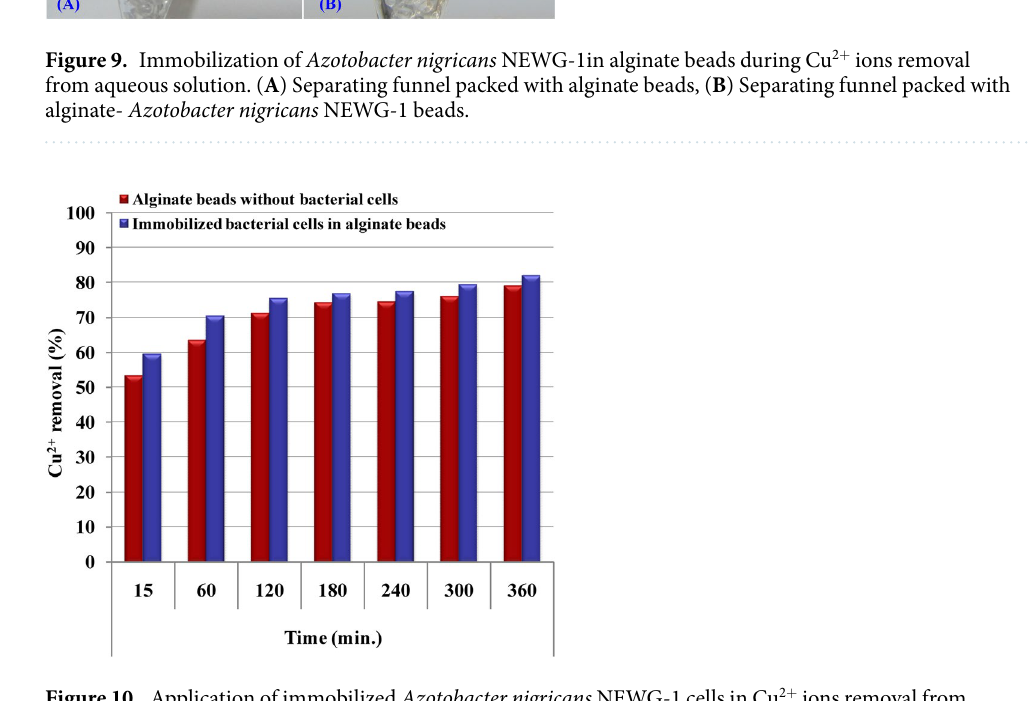
Figure 10. Application of immobilized Azotobacter nigricans NEWG-1 cells in Cu 2 + ions removal from aqueous